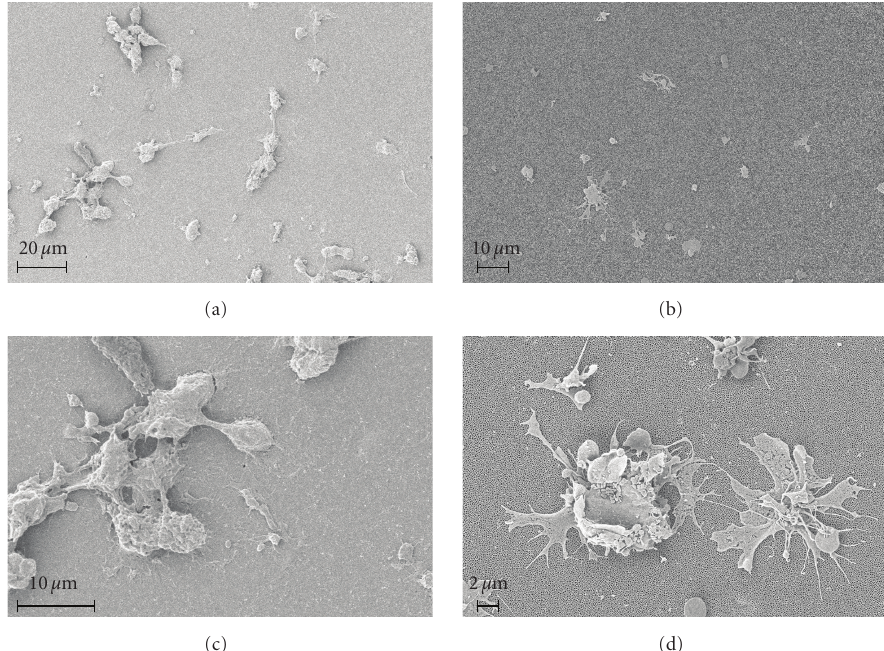
Figure 4: SEM micrographs of monocytes/macrophages after 24 h of incubation on nanoporous alumina. MM on the 200nm-pore membranes ((b) and (d)) show clear signs of activation (rough plasmalemma and extended filipodia), while cells on the 20nm-pore membranes ((a)and (c)) appear more round shaped with little membrane ru ffl ing and no established filipodia extensions. A higher tendency toward cell clustering and fusion was also observed on the 20nm-pore alumina (c).